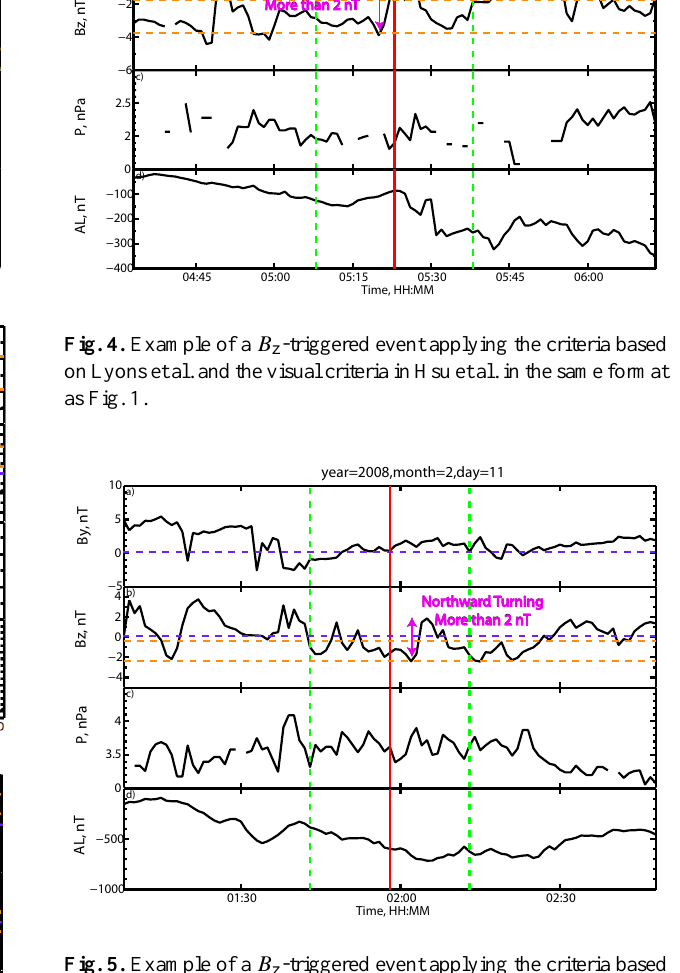
Fig. 5. Example of a B z -triggered event applying the criteria based on Lyons et al. and the visual criteria in Hsu et al. without require- ments for the southward IMF growth phase in the same format as Fig.